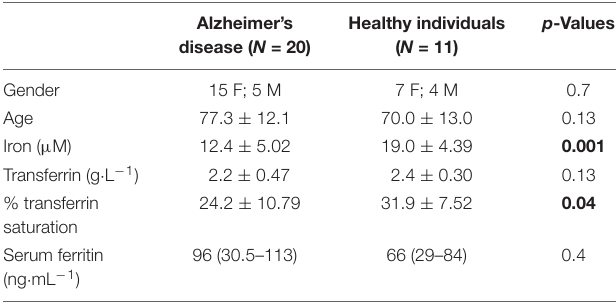
TABLE 1 | Demographics for the healthy and the Alzheimer-type dementia individuals used in this study. Alzheimer’s disease ( N = 20)